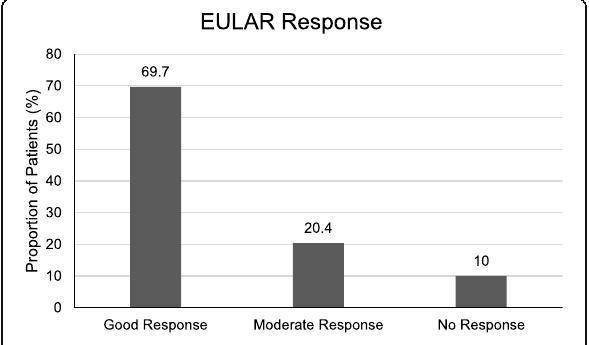
Fig. 1 Response rate based on EULAR